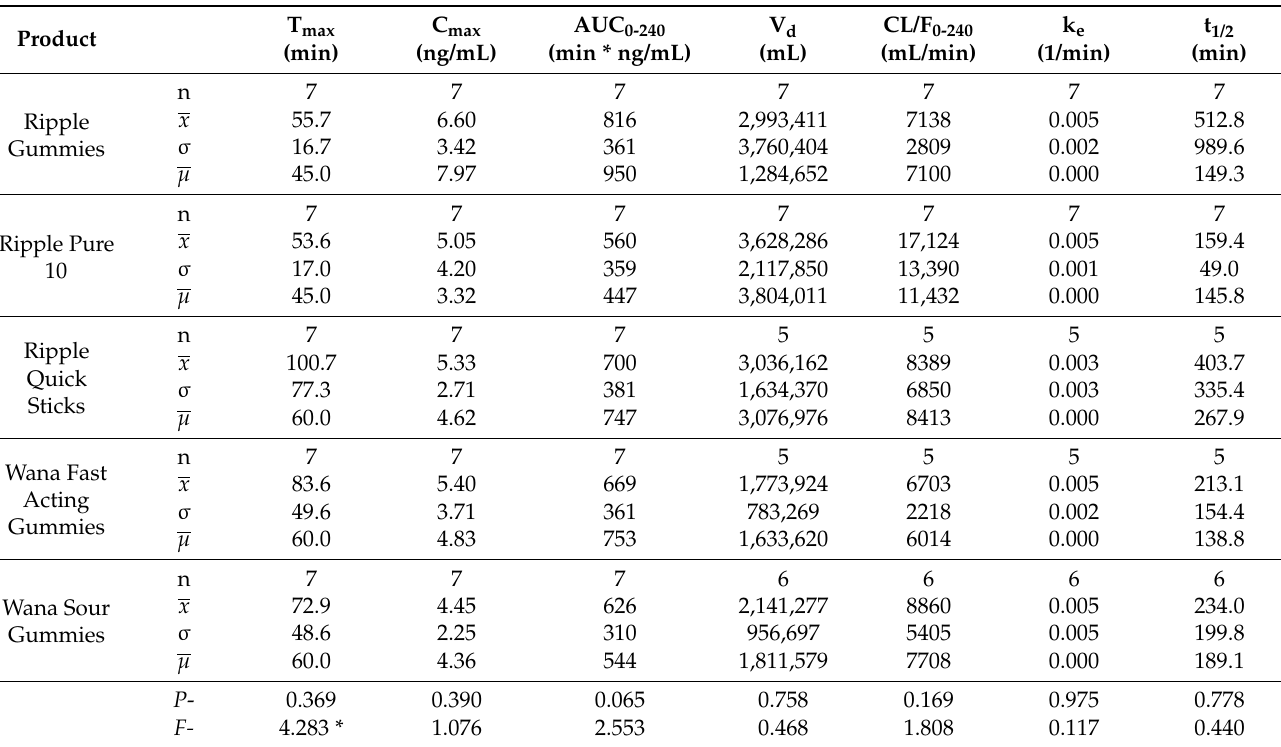
T max : the time to maximum concentration. C max : the maximum concentration. AUC 0-240 : the area under the curve representing total THC-OH exposure between time 0 and end of data collection. V d : the volume of distribution, an estimate of the degree to which THC-OH is distributed in the body tissue vs. the plasma. CL/F 0-240 : the apparent total clearance of the THC-OH from plasma after oral administration. K e : the rate at which the THC-OH is removed from the body. t 1 : the amount of time it takes to decrease the circulating concentration to 2 half of its initial value. All product servings contained 10 mg of THC. x represents mean value. σ represents the standard deviation. µ represents median value. P - represents statistical p -value. F- represents the F -value from the ANOVA table unless depicted by *, in which case this is the Chi-square